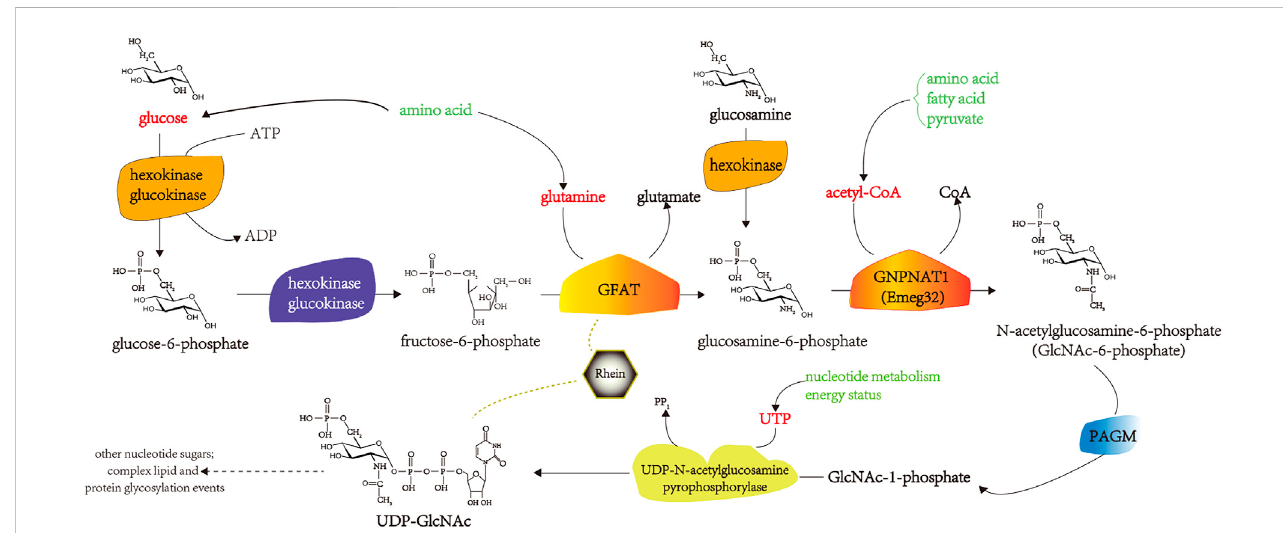
FIGURE 3 ThepharmacologicalmechanismsofrheininimprovingIRinDMbyinhibitingHBPoveractivity.PAGM,Phosphoacetllucosaminemutase;ATP,adenosine triphosphate; ADP, adenosine diphosphate; UDP, uridine diphosphate; UTP, uridine